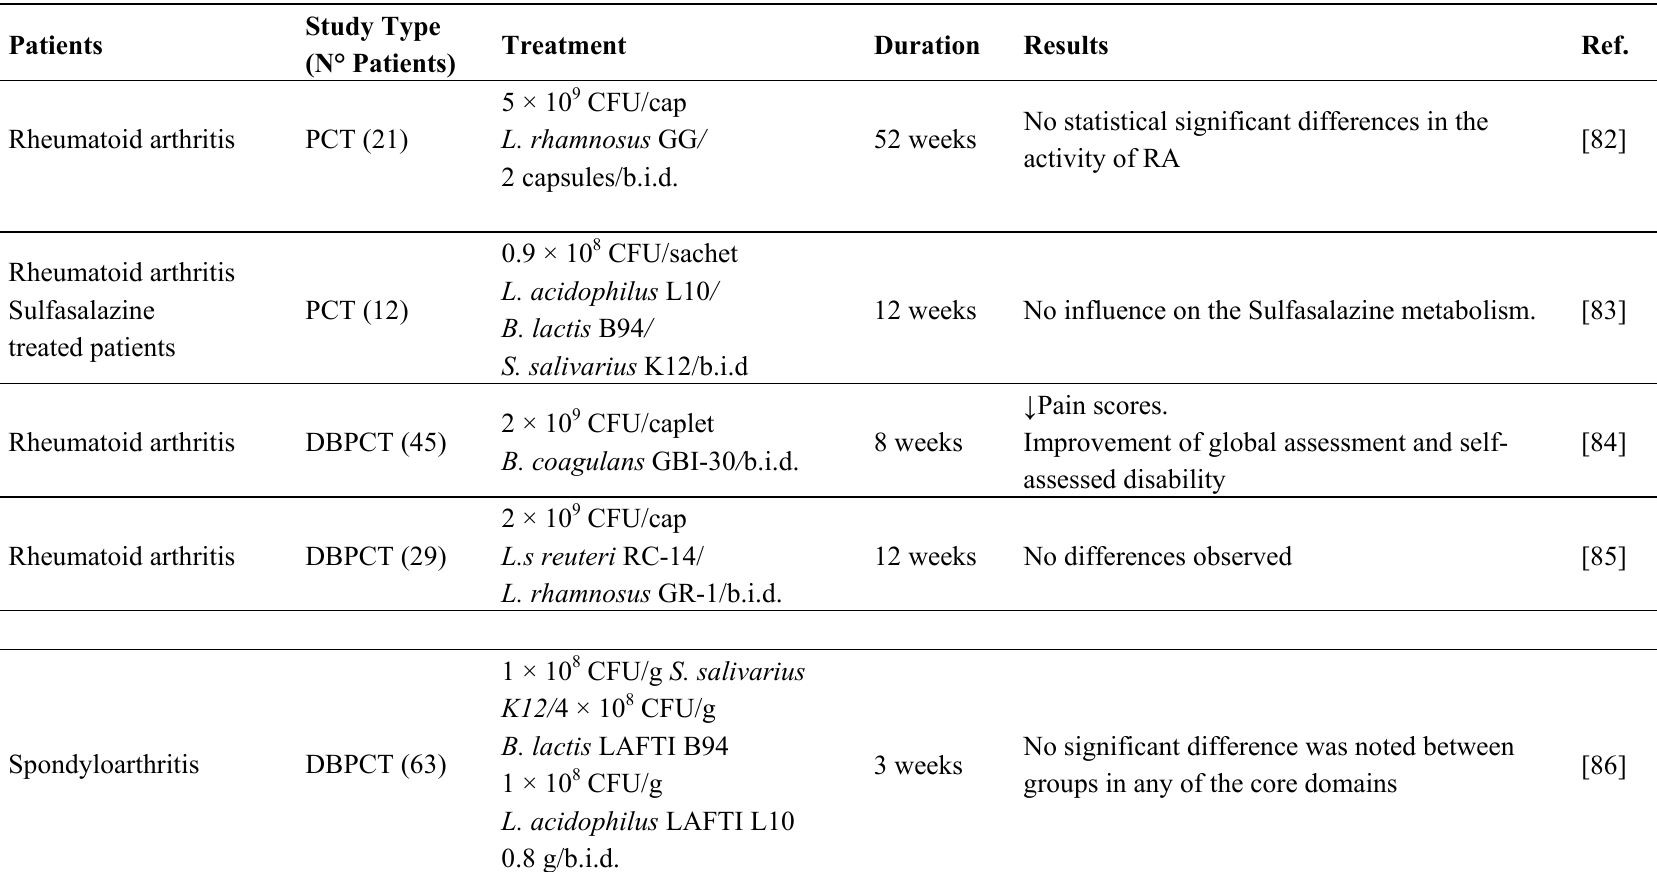
Table 6. Clinical studies of probiotics and joint